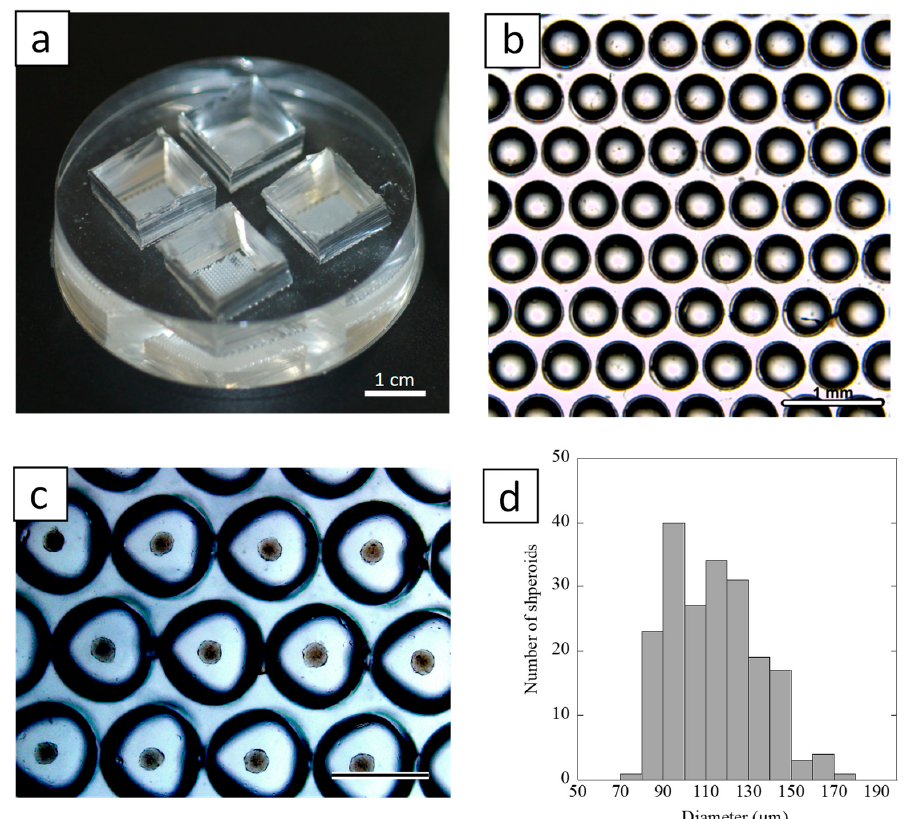
Figure 3. ( a ) A photograph of the spheroid culture chip. Bar = 1 cm. ( b ) Stereo microscopic image of the surface structure of the chip. Bar = 1 mm. ( c ) A light-microscopic image of spheroid formation on the spheroid culture chip at day 2. Bar = 500 µ m. ( d ) Histogram of size distribution of spheroids formed on the culture chip at day 2 (n = 336).